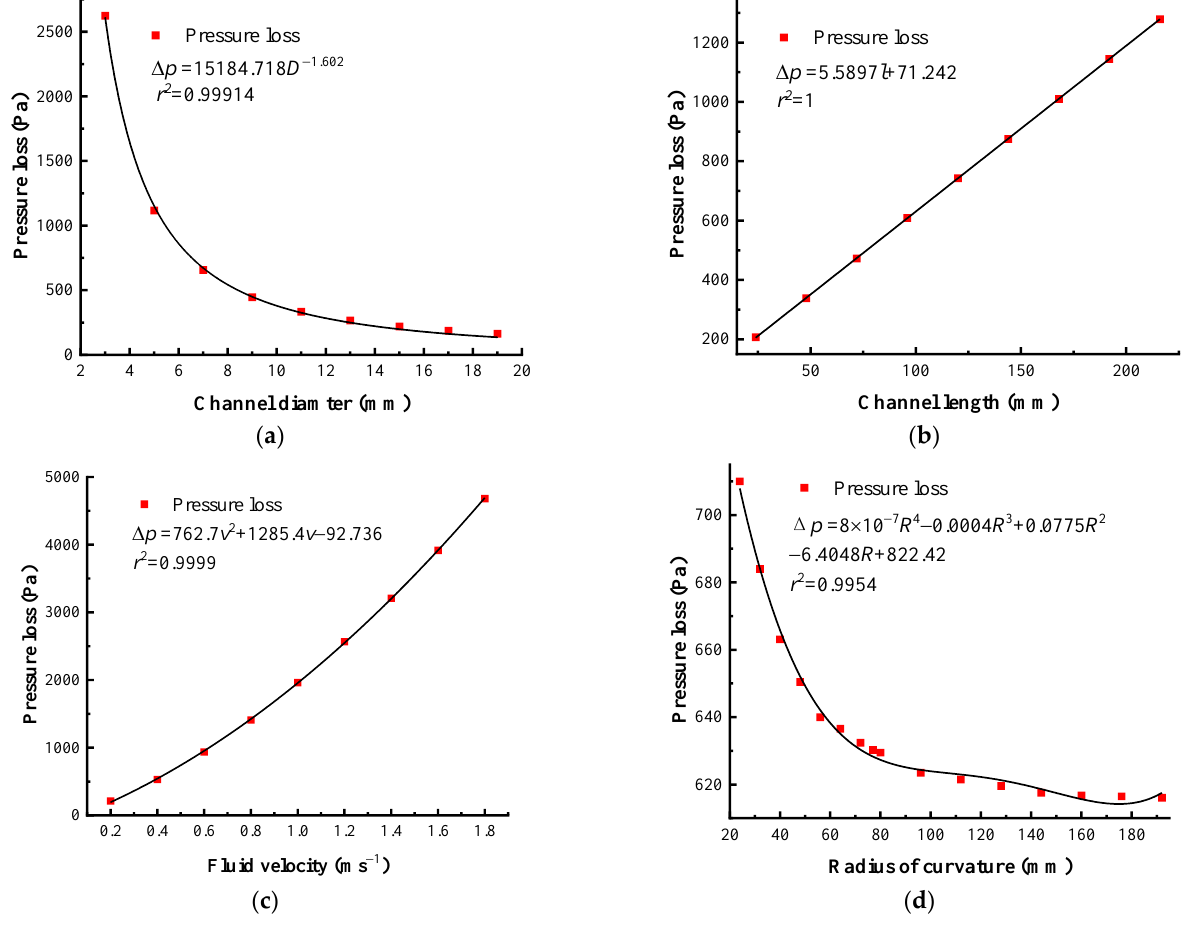
Figure 5. Relationship curve between pressure loss ( ∆ p ) and flow channel design parameters: ( a ) relationship curve between D and ∆ p ; ( b ) relationship curve between l and ∆ p ; ( c ) relationship curve between v and ∆ p ; ( d ) relationship curve between R and ∆ p